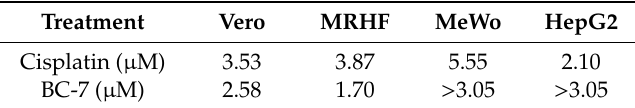
Table 2. SI (selectivity index) values for BC-7 and cisplatin for HeLa cells compared to MeWo, HepG2, Vero, and MRHF